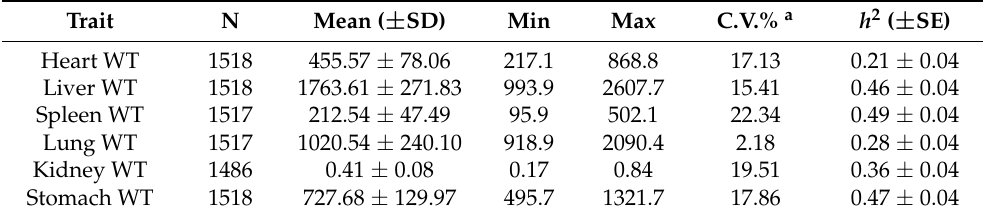
Table 1. Phenotypic statistics and heritability estimates for Heart WT, Liver WT, Spleen WT, Lung WT, Kidney WT, and Stomach